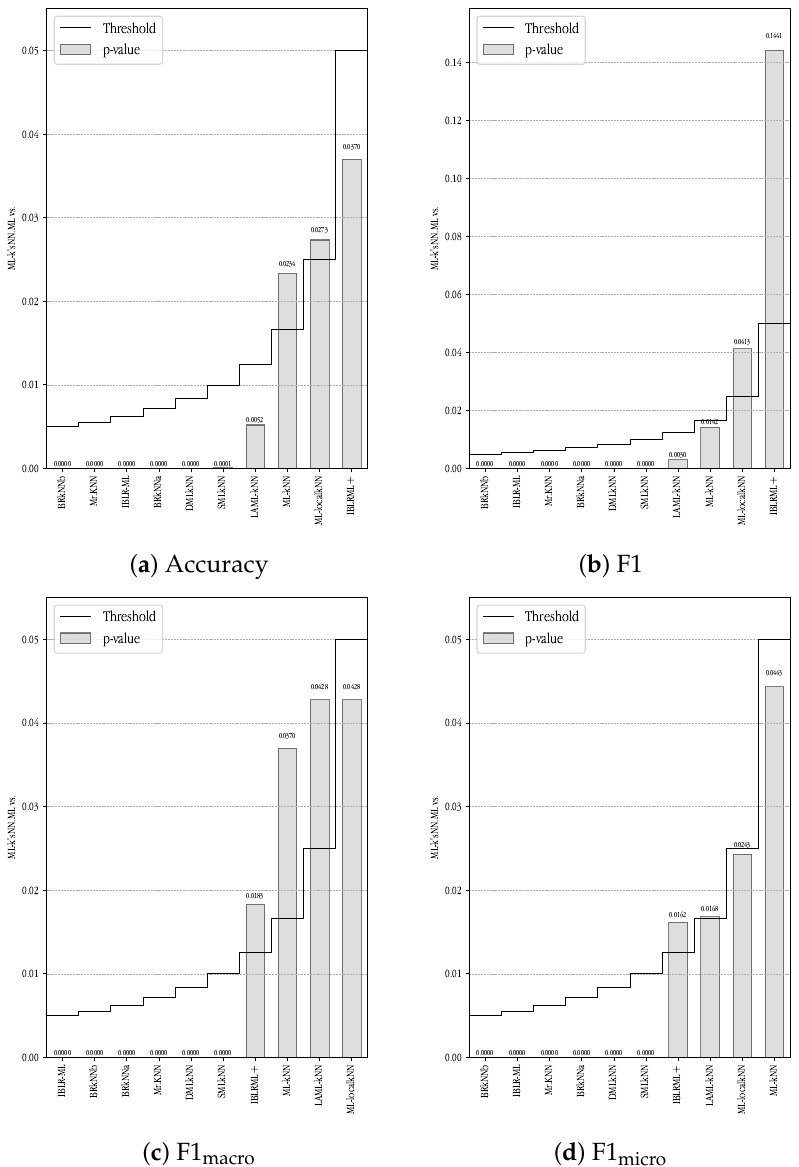
Figure 10. Holm test for the different variants of ML-kNN and the different classification